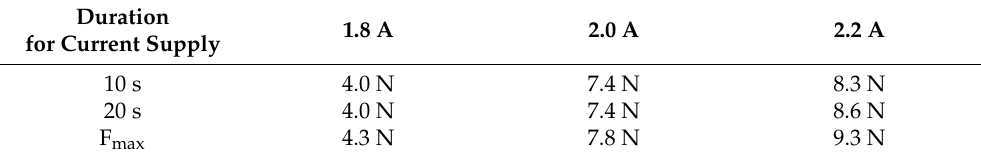
Figure 4. ( a ) Experiment setup for the force measurement of the SMA spring; and ( b ) Force–time relationship graph of one SMA spring with the increasing current. Table 3. Force measurement of the SMA spring by supplying different electric currents. Table 3. Force measurement of the SMA spring by supplying different electric